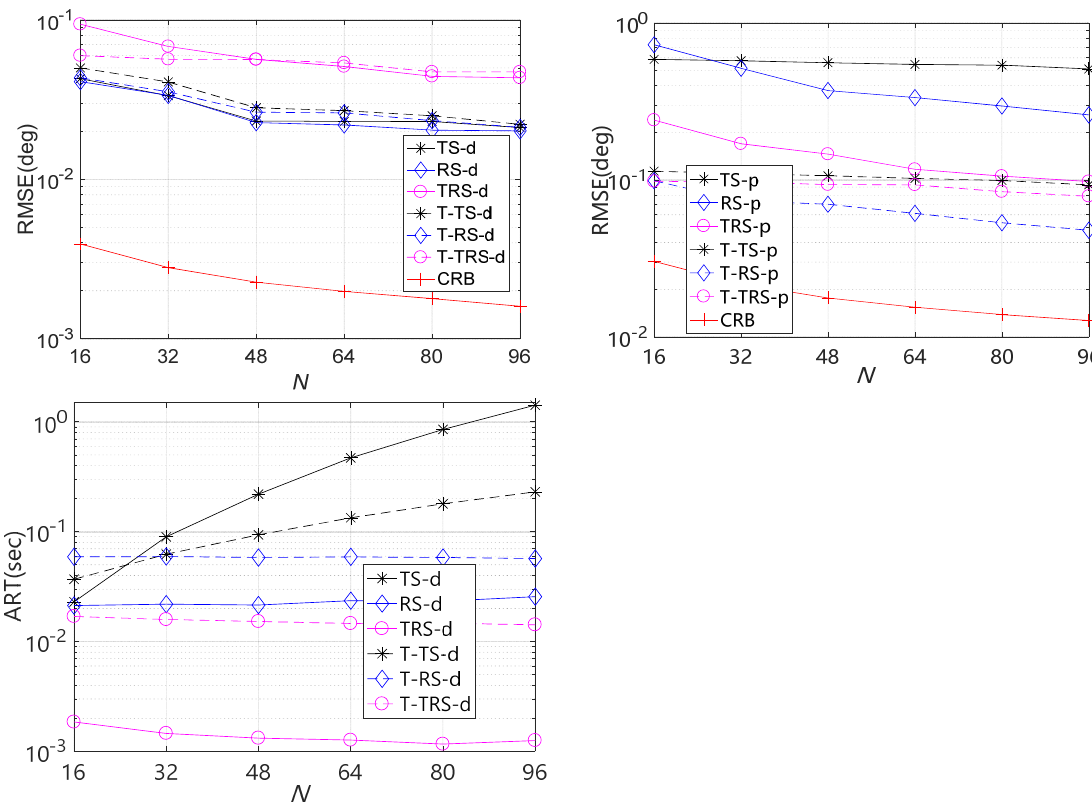
Figure 6. RMSE and ART comparisons versus N in Case (I).